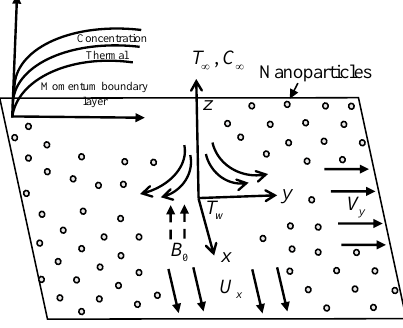
Figure 1. The coordinate system of the physical